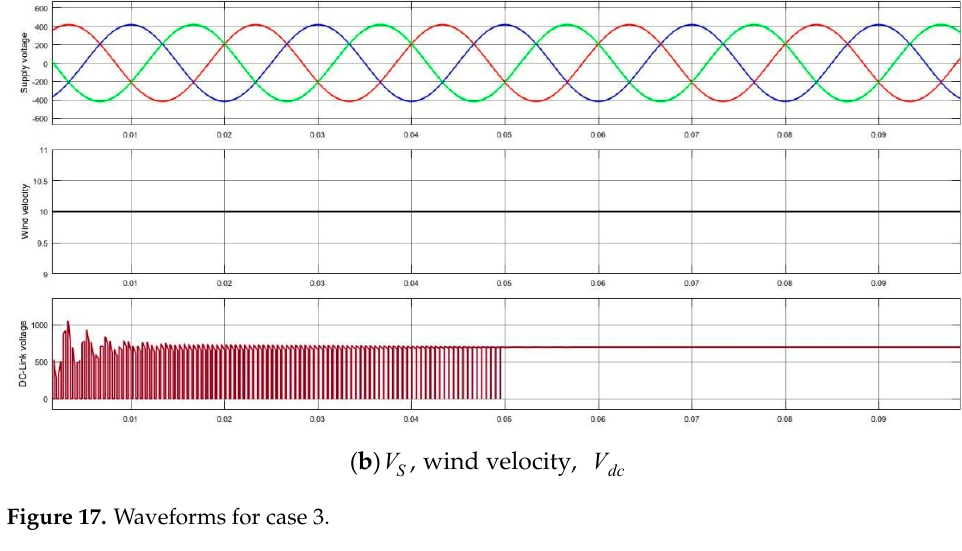
Figure 17. Waveforms for case 3.